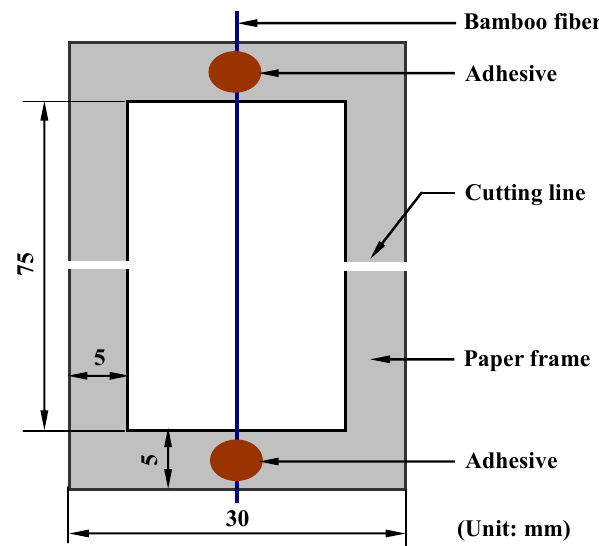
Figure 1. Use of a paper frame to glue fiber specimen.